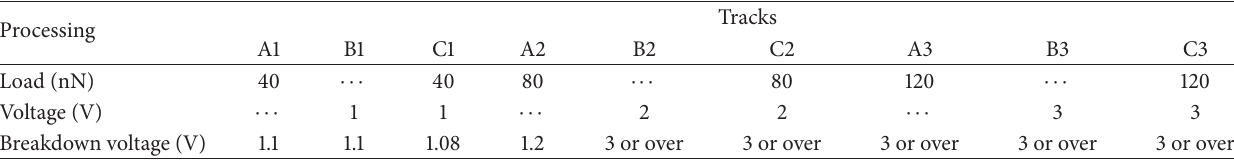
Figure 24: Surface morphology and I-V characteristic of areas processed at different loads and voltages of (closed circle) 120nN, 0 V, (closed triangle) 0 nN, 3 V, and (closed square) 120 nN, 3 V. Table 2: Breakdown voltages and processing